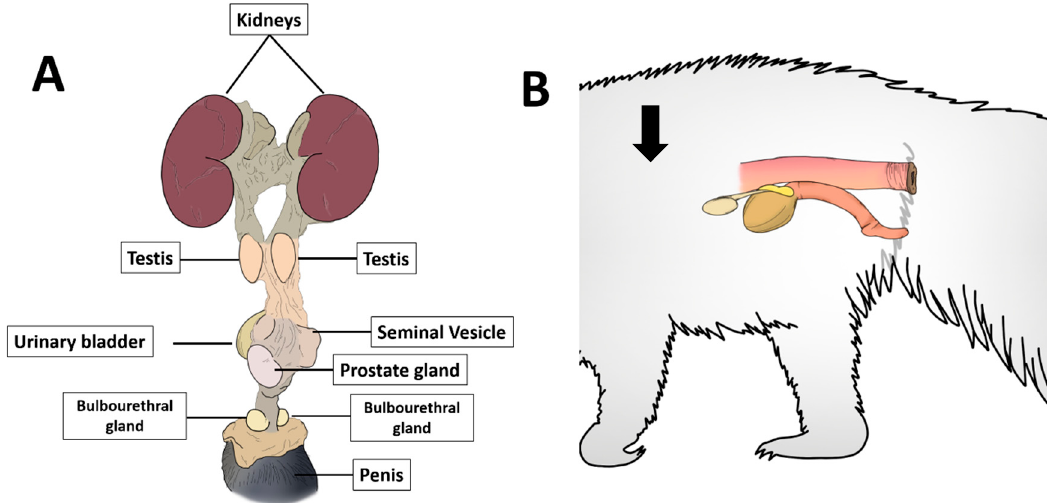
Figure 1. Schematic representation of anatomic localization of giant anteater prostate gland. ( A ): representation of the prostate gland dorsal do the urinary bladder (and ventral to the rectum. ( B ): schematic representation of the giant anteater urogenital tract showing the testicles cranial to the urinary bladder, in which it is possible to observe dorsally the prostate, all lying within the abdominal cavity (arrow).